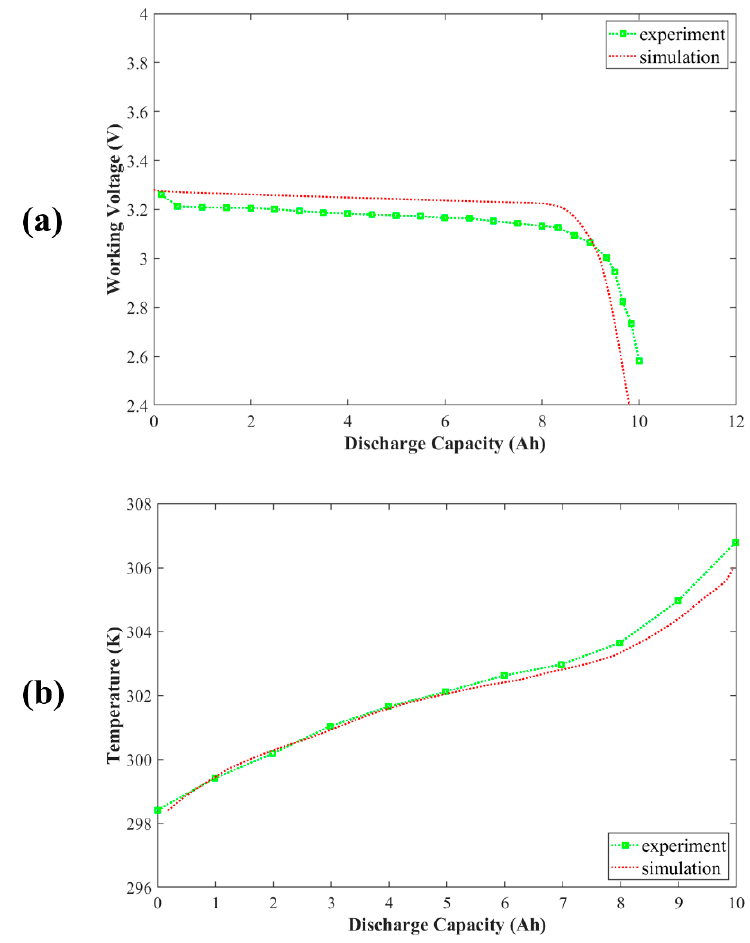
Figure 3. Comparison of numerical results of working voltage ( a ) and temperature ( b ) with experi- mental results [23] during 1C galvanostatic discharge under natural convection conditions.